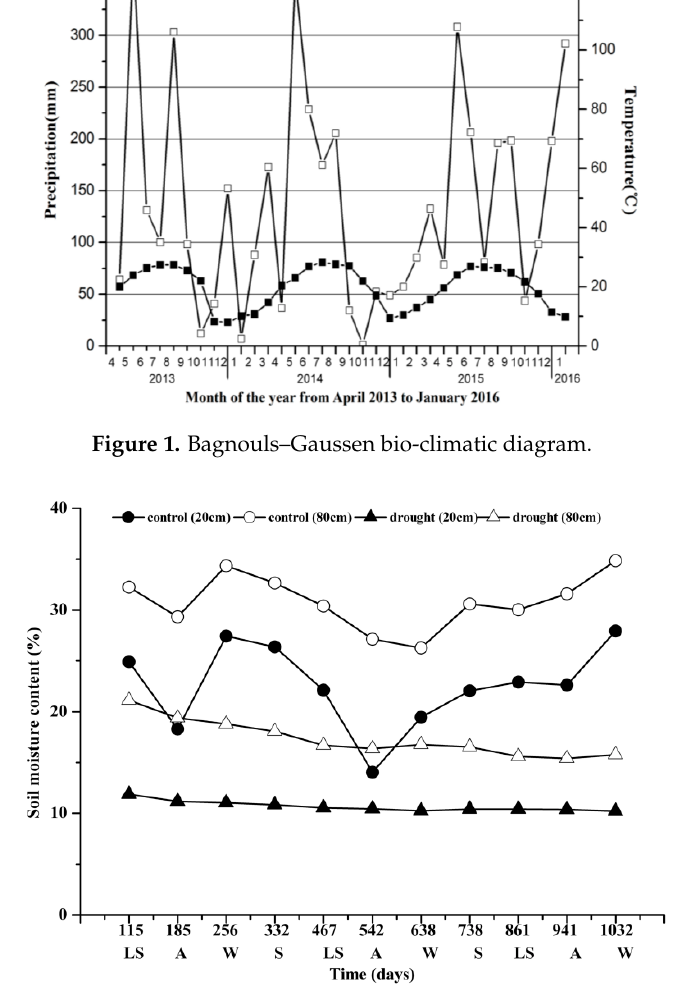
Figure 2. Relative change in daily average soil moisture content across the study period from August 2013 to January 2016 in the control and drought plots. Samples were collected in late summer (LS), autumn (A), winter (W), and late spring (S).